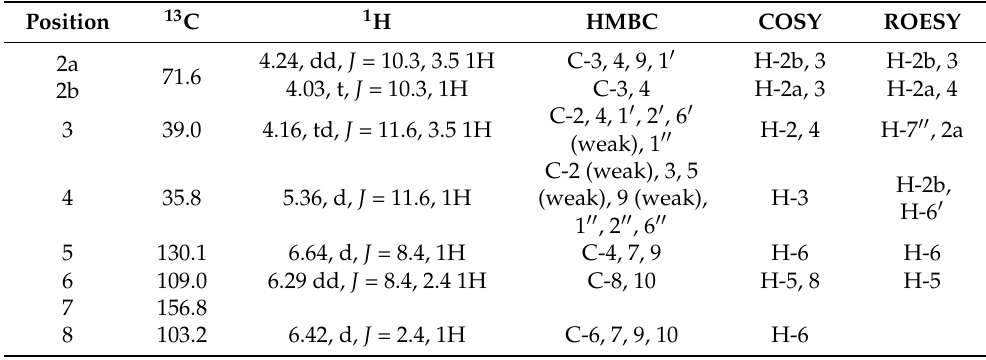
Table 1. 1 H (700 MHz), 13 C (175 MHz), HMBC, COSY, and ROESY NMR data for compound 1a ( δ in ppm, J in Hz, acetone- d 6